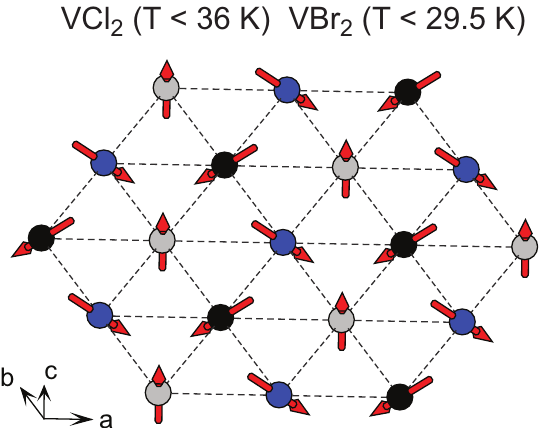
Figure 4. The 120 ◦ magnetic structure determined for VCl 2 and VBr 2 . The image shows a single triangular net of V atoms lying in the ab plane. Moments on the grey atoms are along the c axis. Moments on the black and blue atoms lie in the ac plane and are rotated by an angle of ± 120 ◦ from the c